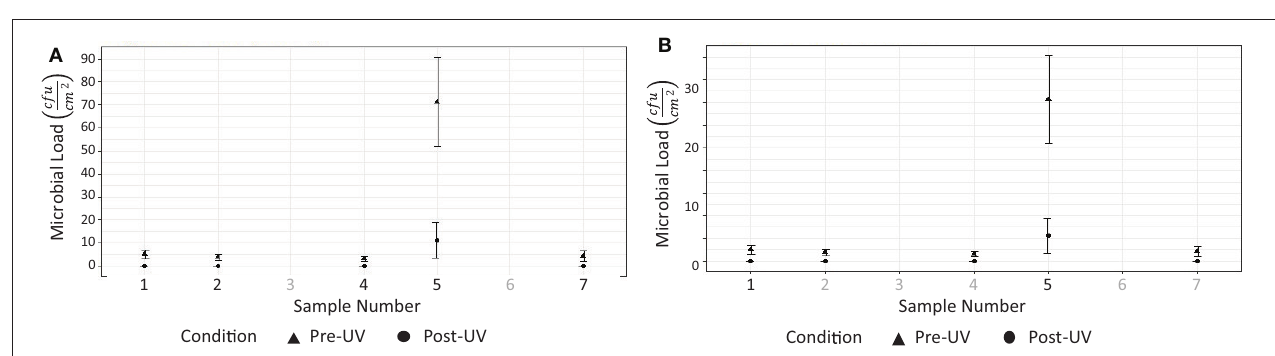
FIGURE 8 | Results from testing at hospital 2. (A) Reduction of measurable bacterial load on surfaces after 15 disinfection period (testing day 1). (B) Reduction of measurable microbial load on surfaces after 15 disinfection period (testing day 2).